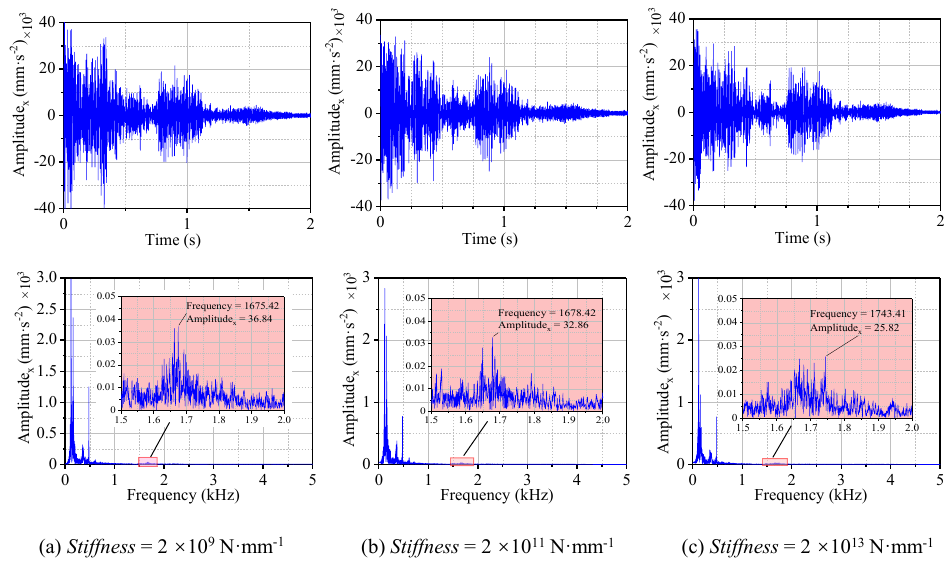
Figure 11. Vibration acceleration displacement and frequency spectrum of N-502 under different stiff- ness values of bearing support with the μ 3 friction coefficient.